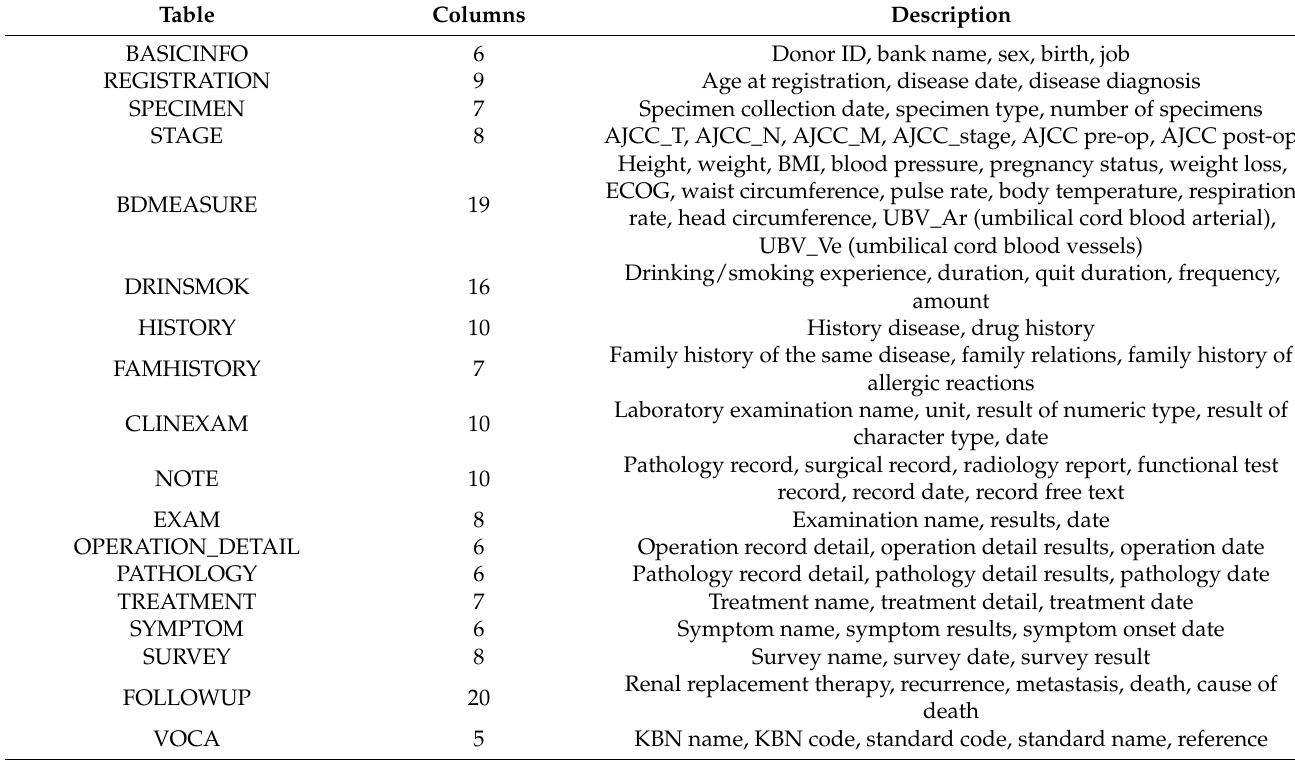
Table 1. KBN clinical common data model table. Table